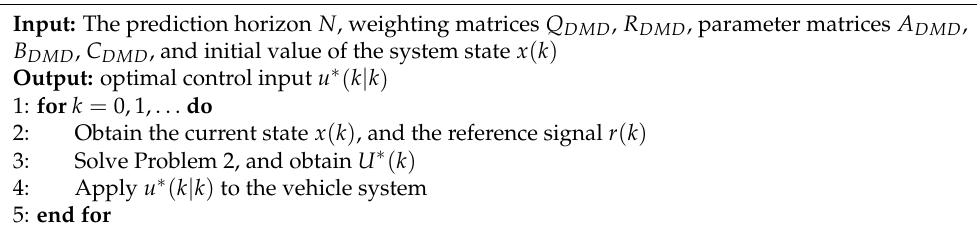
Algorithm 3 DMDc-MPC based on Koopman